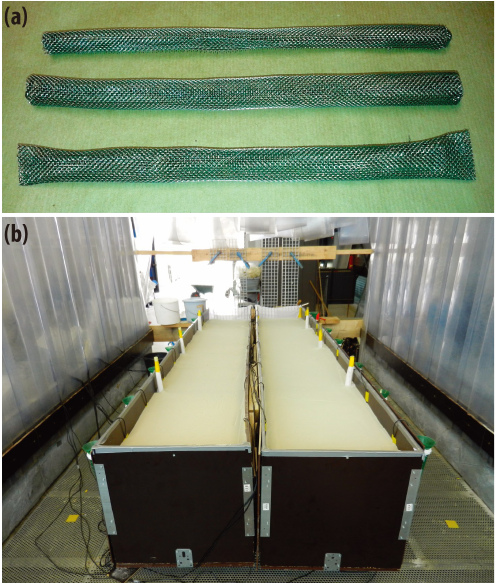
Figure 6. ( a ) example of a set of macropores made of stainless steel mesh with a size of approximately 40 cm; and ( b ) the two hillslopes in a steel frame inside the rainfall simulator used for the experiment, viewed from upslope. Green rain gauges are positioned at the borders of the hillslopes and the yellow tubes were used for groundwater